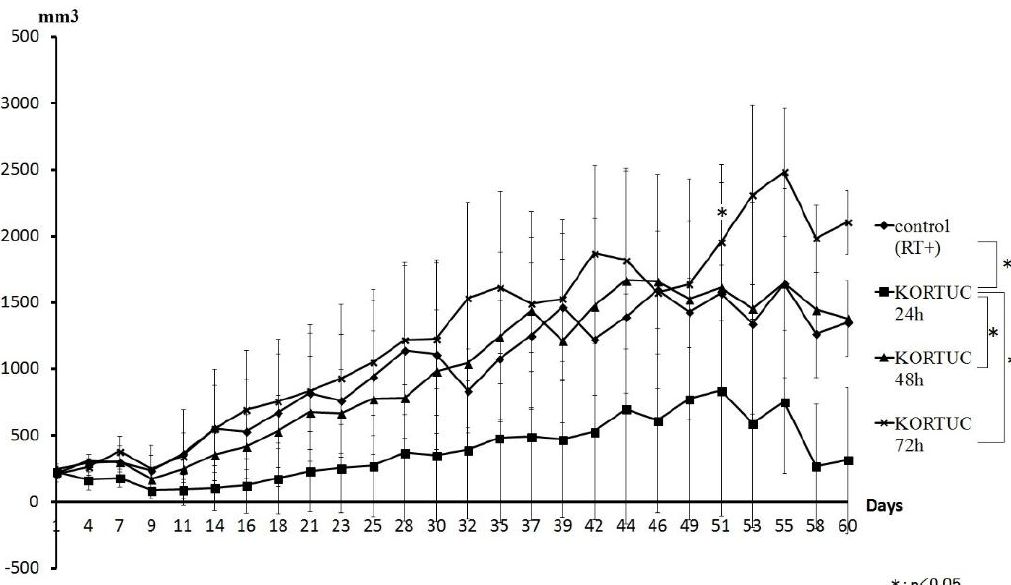
Figure 4. Comparison of the tumor volume curves of between the KORTUC and control groups. The KORTUC (24 h) group showed inhibition of increases in tumor volume compared with the other groups. For groups with a greater time to irradiation, no inhibition of tumor volume was identified. The KORTUC (72 h) group did not show inhibition of increases in tumor volume compared with the other groups. During the observation period, complete resolution of tumors occurred in the KORTUC group.